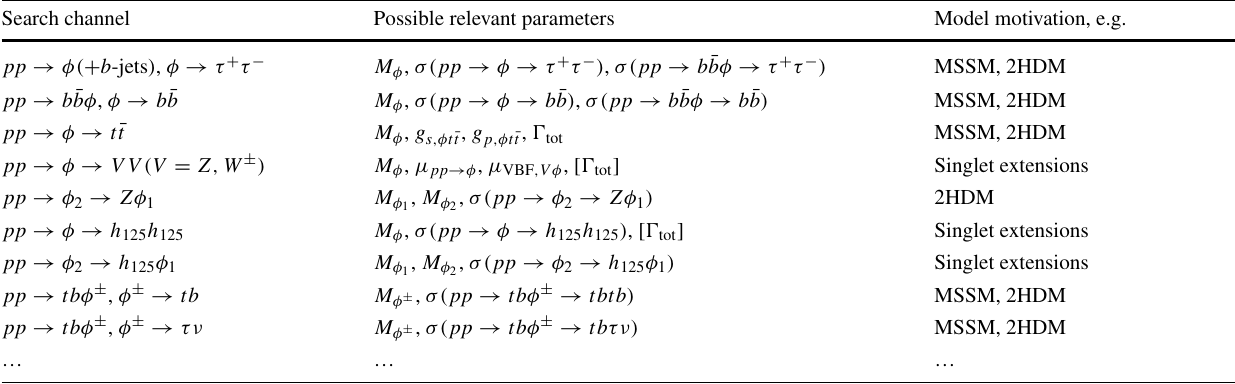
Table 6 A wishlist for the publication of exclusion likelihoods in sev- brackets seem less important), and the right column lists examples of eral Higgs search channels. The left column denotes the search channel, BSM models for which the result would be valuable themiddlecolumnthepossiblerelevantparameters(quantitiesinsquare Search channel Possible relevant parameters Model motivation,